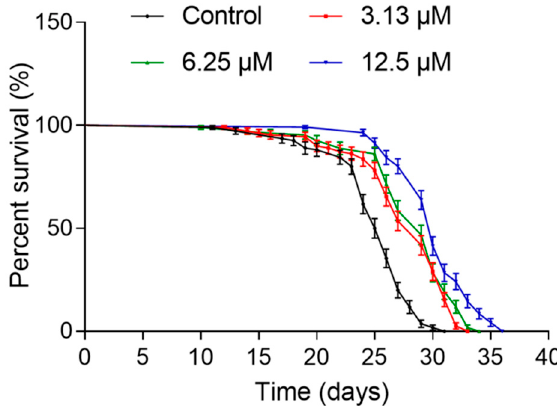
Figure 2. Effect of nobiletin (NOB) on lifespan of C. elegans. N2 worms were treated without NOB (control) or with NOB (3.13, 6.25 or 12.5 μ M) from day 0 adult (L4 larvae) to death at 20 °C. The percentage of live animals was plotted against adult days. Detailed parameters are presented in Table 2. Table 2. Effect of nobiletin (NOB) on lifespan of C. elegans.